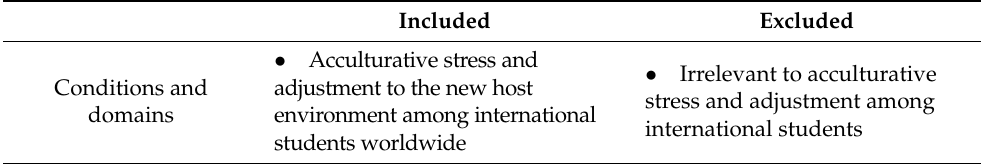
Table 1. The inclusion and exclusion criteria according to the statement of PICOS